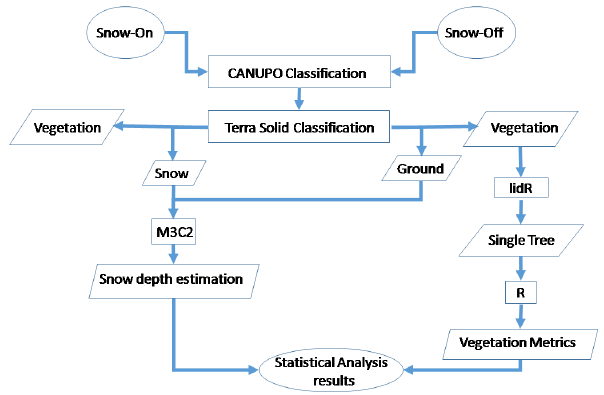
Figure 3. TLS data processing